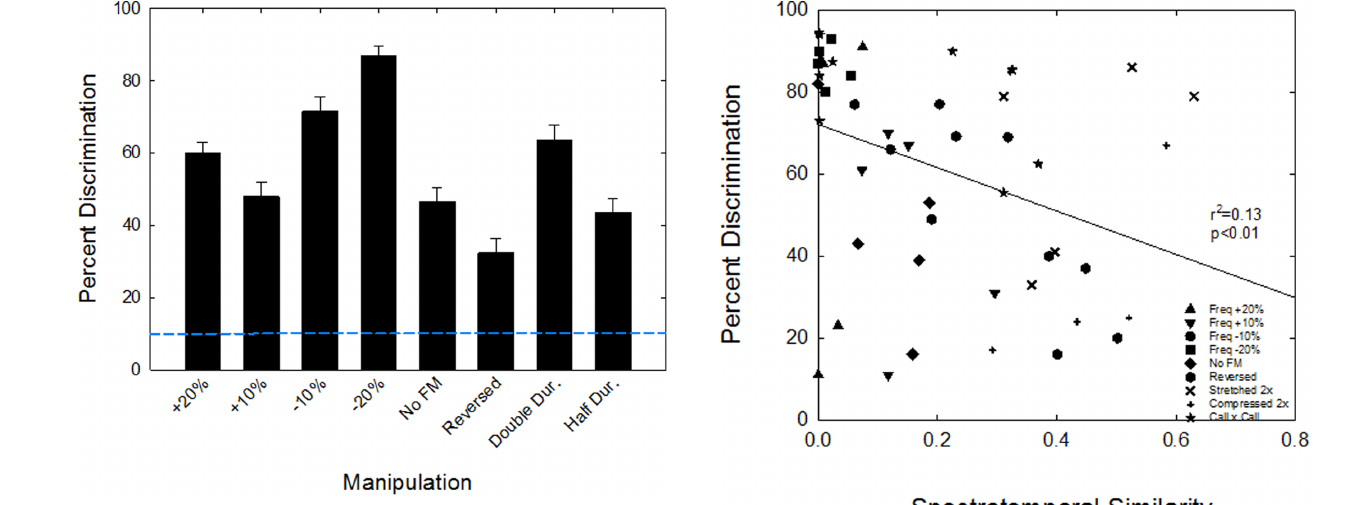
Figure 5. Correlation between spectrotemporal similarity and discrimination performance. Percent correct discrimination as a function of spectrotemporal similarity for all vocalization discrimina- tions in the first experiment and all vocalizations versus their manipulations in the second experiment.